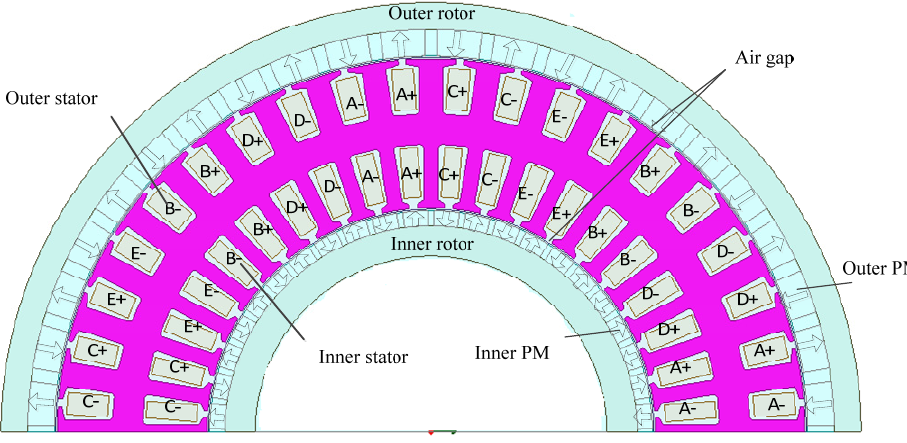
Table 13. The details of electromagnetic torque under double phase open circuit in both sides of the motor fault condition. Double ‐ Phase Open ‐ Circuit in Both Sides of Motor Fault Types